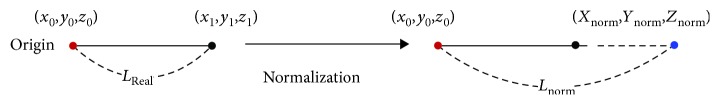
Normalization of body segment length.